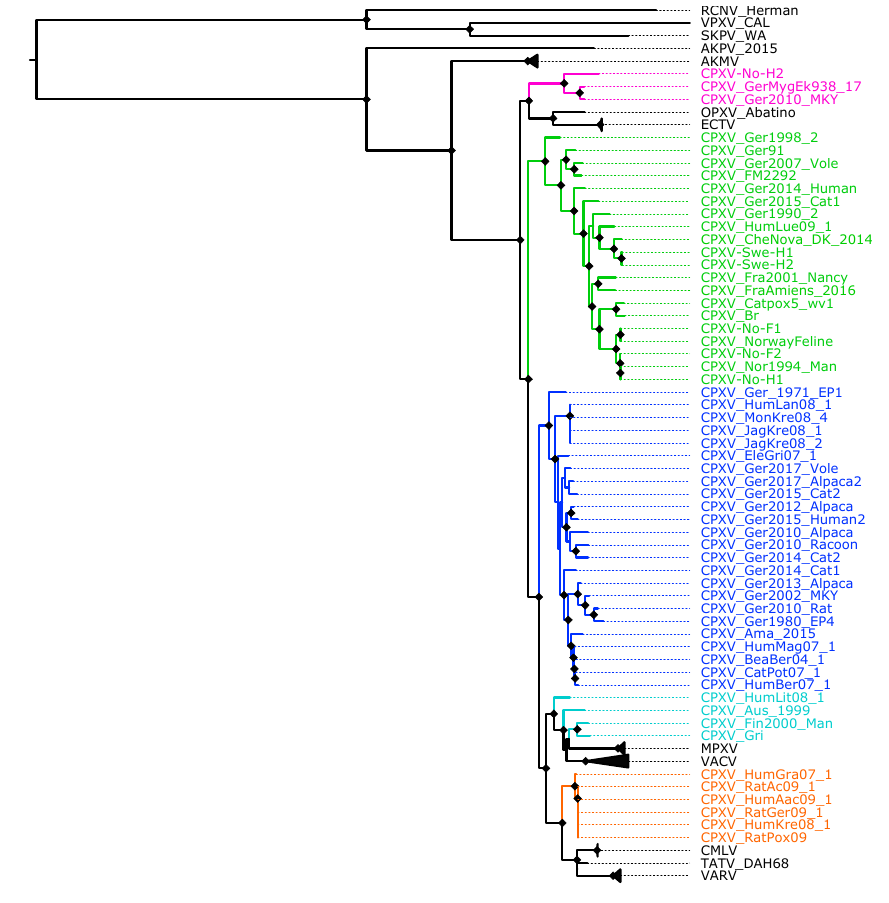
Figure 2. Maximum likelihood phylogenetic tree of 87 orthopoxvirus core genome. Bootstrap values were inferred from 1000 rapid bootstrap replicates. Diamonds at the nodes indicate bootstrap values > 80%. The scale indicates substitution per site. The main five cowpox virus (CPXV) clusters were highlighted in different colors: pink (Ectromelia-Abatino-like CPXV), blue (CPXV-like 1), green (CPXV-like 2), turquoise blue (Vaccinia-like CPXV) and orange (Variola-like CPXV).